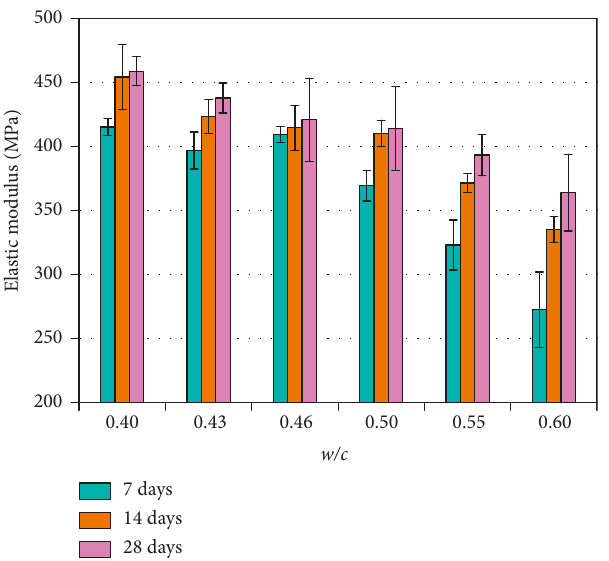
Figure 10: Average elastic modulus and error of the gangue concrete at various ages.